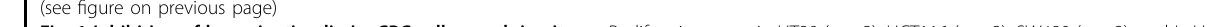
Fig. 1 Inhibition of hypusination limits CRC cell growth in vitro. a Proliferation assay in HT29 ( n = 3), HCT116 ( n = 3), SW480 ( n = 3), and LoVo ( n = 3) cells treated with different concentrations of GC7 (0.1, 1, 10, 50, and 100 μ M) for 24, 48, and 72 h (upper panels). b Cell viability assay (MTT) ( n = 3) of HCT116 treated for 48 h with 100 μ M GC7, 200 μ M DFMO, 10 μ M Cisplatin, or control vehicle. c Western blot analysis of full-length and cleaved PARP, tubulin (loading control) in HCT116 cells treated with 100 μ M GC7, 200 μ M DFMO, 10 μ M Cisplatin, or control vehicle for 48 h. d Flow cytometry analysis ( n = 3) of HCT116 cells stained with annexin V after 24 h from treatments with 100 μ M GC7, 200 μ M DFMO, 10 μ M Cisplatin, or control vehicle. e Cell cycle pro fi le ( n = 3) of HCT116 cells treated with 100 μ M GC7, 200 μ M DFMO, 10 μ M Cisplatin, or control vehicle for 24 h. f Left, HCT116 cells were infected with lentiviruses expressing DHPS (shDHPS) or control (SCR) shRNAs for 72 h. After infection, cells were incubated with 100 μ M GC7 and counted at the indicated time points or treated with 100 μ M GC7 for 48 h and MTT assay performed (middle). Right, western blotting showing DHPS, Hyp-EIF5A, EIF5A, and Vinculin (loading control) levels before treatment. g Left, HCT116 cells were infected with lentiviruses expressing EIF5A (shEIF5A) or control (SCR) shRNAs for 72 h. After infection, cells were incubated with 100 μ M GC7 and counted at the indicated time points or treated with 100 μ M GC7 for 48 h and MTT assay performed (middle). Right, western blotting showing EIF5A, Hyp-EIF5A, and Vinculin (loading control) levels before treatment. For statistical analysis: ns not signi fi cant, * p < 0.05, ** p < 0.01, *** p < 0.001, by one-way ANOVA. Data represent the mean ± SD of experiments performed in triplicates and repeated at least three